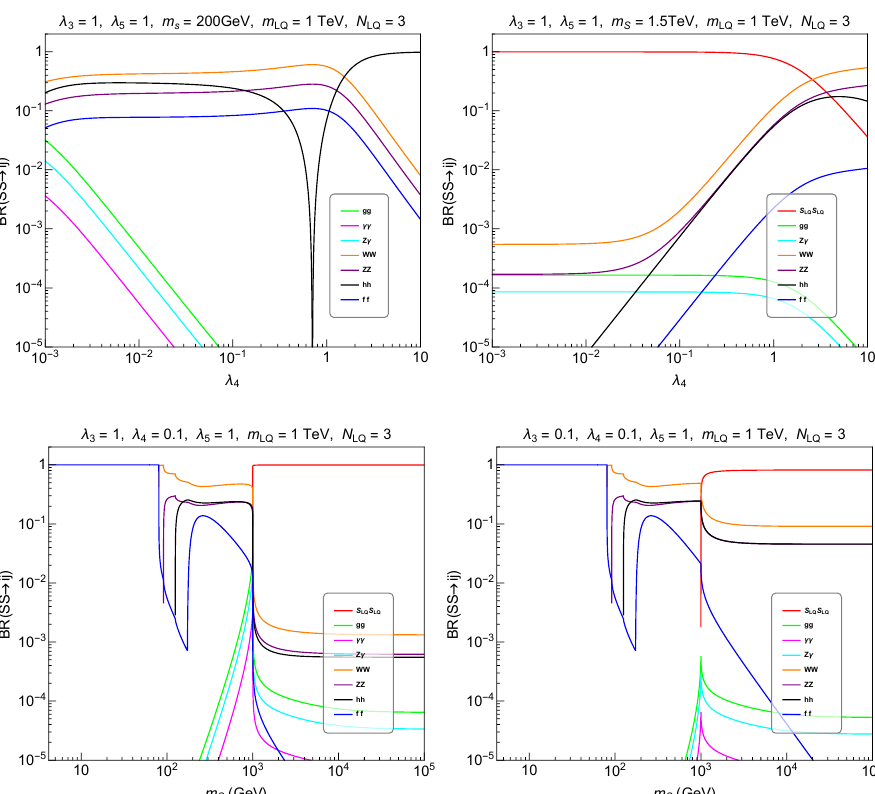
Figure 5 . The same as in (cid:12)gure 4, but in models with triplet scalar